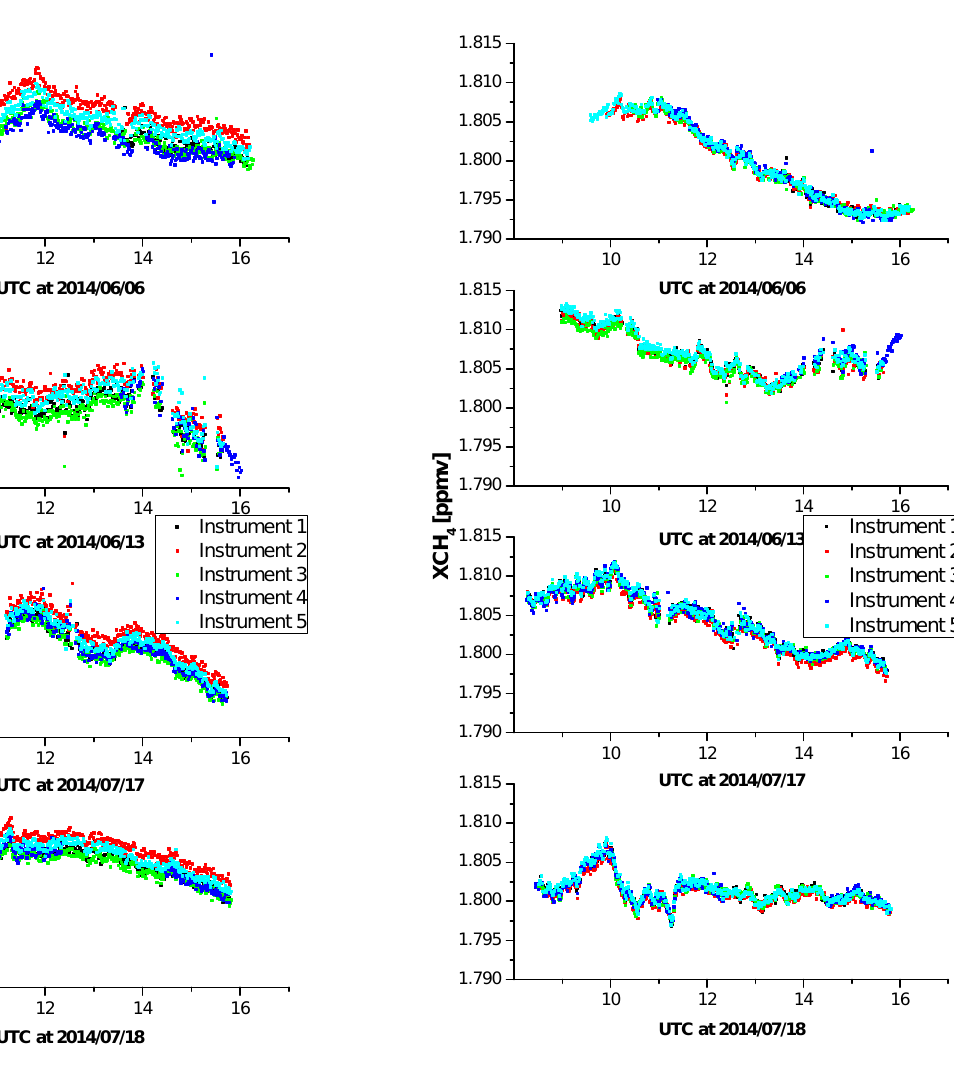
Figure 7. Uncalibrated XCO 2 values for all instruments. Experi- ments and measurement days are the same as for O 2 .